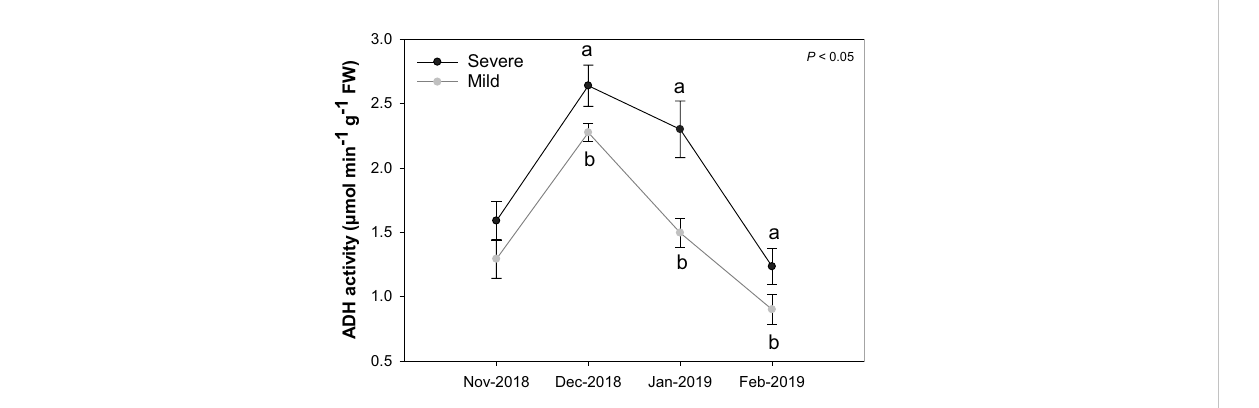
FIGURE 4 Alcohol dehydrogenase enzyme activity (µmol min -1 g -1 FW) in buds of Huanglongbing (HLB)-affected ‘ Hamlin ’ trees. Data are presented as means ± standard deviation (n=4). Different letters indicate signi fi cant differences among severe and mild trees. Grey and black colors represent mild and severe trees,